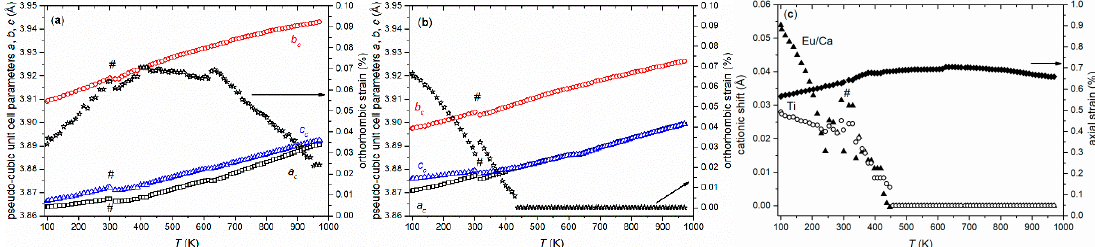
Figure 6. Pseudocubic unit cell parameters a c , b c , and c c of Eu 0.8 Ca 0.2 TiO 3– δ extracted from temperature- dependent PDF analysis using Ima 2 symmetry for different ranges 2 ≤ r ≤ 20 Å ( a ) and 20 ≤ r ≤ 50 Å ( b ) together with the determined orthorhombic strain (open stars). Determined shifts of the cations from the ideal position together with the axial strain based on the range 2 ≤ r ≤ 20 Å ( c ). The # marks deviations resulting from the change from cryostat to hot air blower.